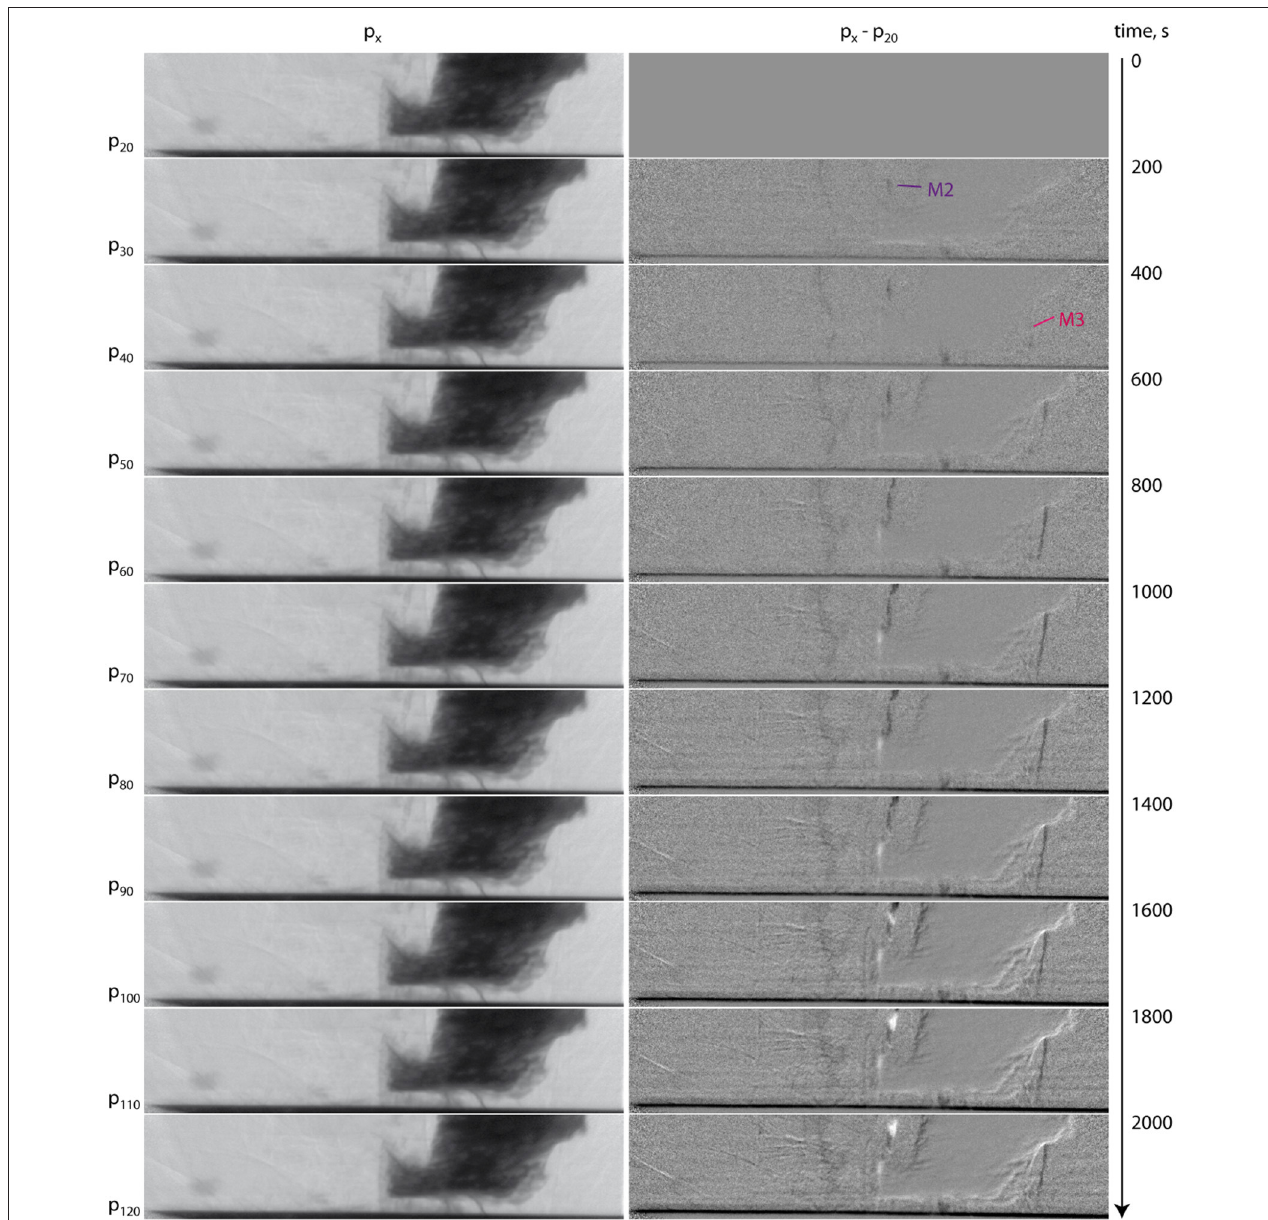
FIGURE 6 | Series of radiographic projections capturing melt migration during the same heating cycle as shown in Figure 5 . The initial reference frame for p x -p 0 images (right hand side) is p 20 to highlight changes later in the heating cycle. Only every 10th frame in the movie is shown here to highlight slower changes in melt geometry. Discrete melt movements M2 and M3 are labeled on projections where a change is first observed. Further melt movement occurs to the left of M2 through a sub-vertical melt channel/vein, although the orientation of this relative to the 2D plane makes it harder to track motion effectively. Changes across the whole